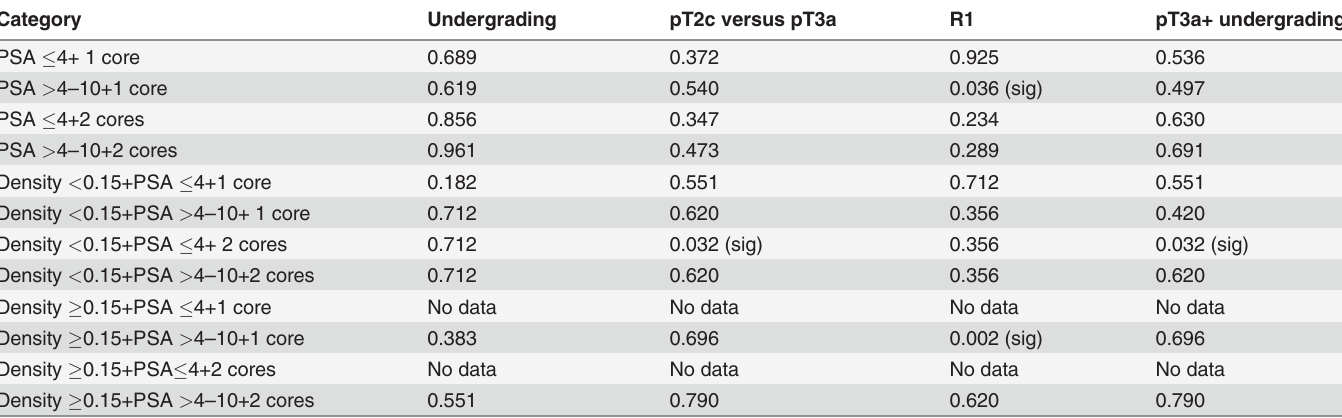
Table 9. Multivariate model.